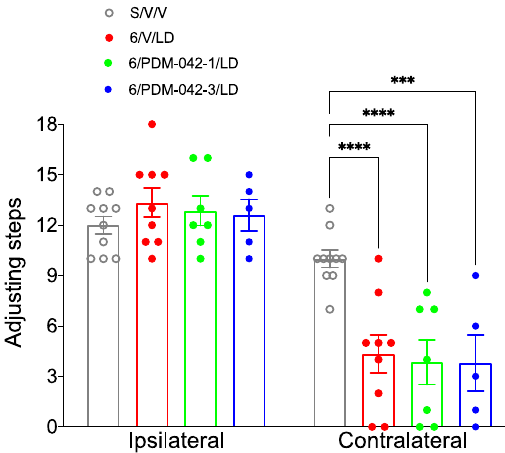
Figure 7. Effects of chronic administration of the PDE10A inhibitor PDM ‐ 042 on the stepping test. Low (1 mg/kg) and high (3 mg/kg) doses of PDM ‐ 042 did not interfere with the number of adjusting steps performed with the ipsilateral forelimb. Additionally, PDM ‐ 042 did not interfere with the antiparkinsonian activity of L ‐ DOPA (*** p < 0.01, **** p < 0.01 vs. S/V/V group, two ‐ way RM ‐ ANOVA and Holm ‐ Sidak post ‐ hoc test). Data expressed as mean ± SEM. Results are derived from n = 9 animals in the 6/V/LD group, n = 7 animals in the 6/PDM ‐ 042 ‐ 1/LD group, and 5 animals in the 6/PDM ‐ 042 ‐ 3/LD group.